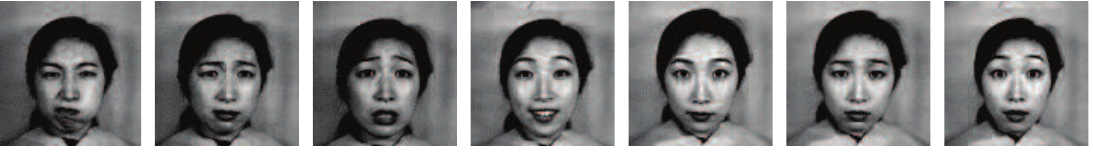
Figure 10. Examples of images in the JAFFE database. The emotions from left to right are: anger, disgust, fear, happy, sad, surprise, and neutral.